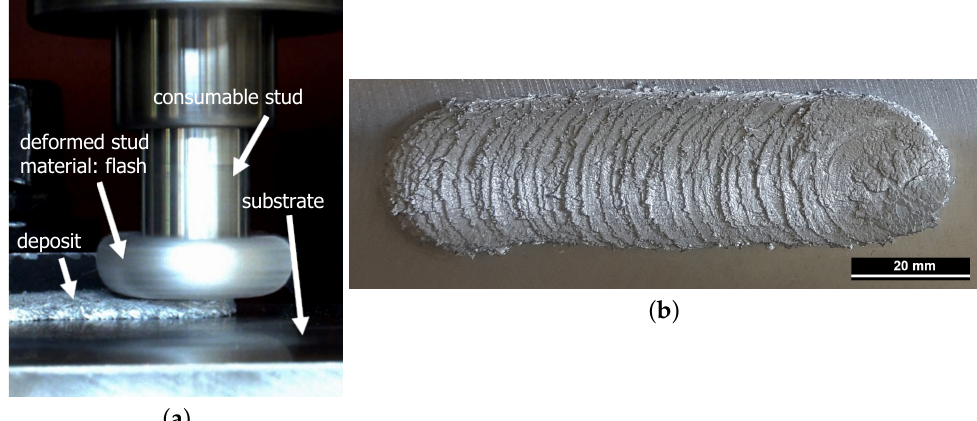
Figure 1. ( a ) Photograph of the FS process and ( b ) photograph of an FS deposited coating from an Al alloy with 14.6%